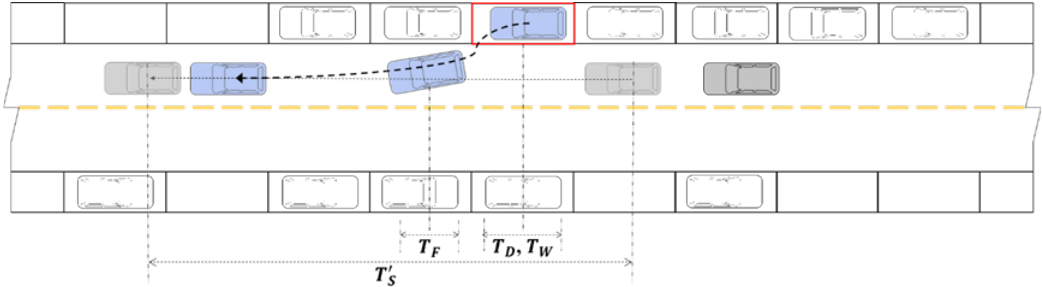
Figure 3. Schematic diagram of a vehicle exiting a parking space.